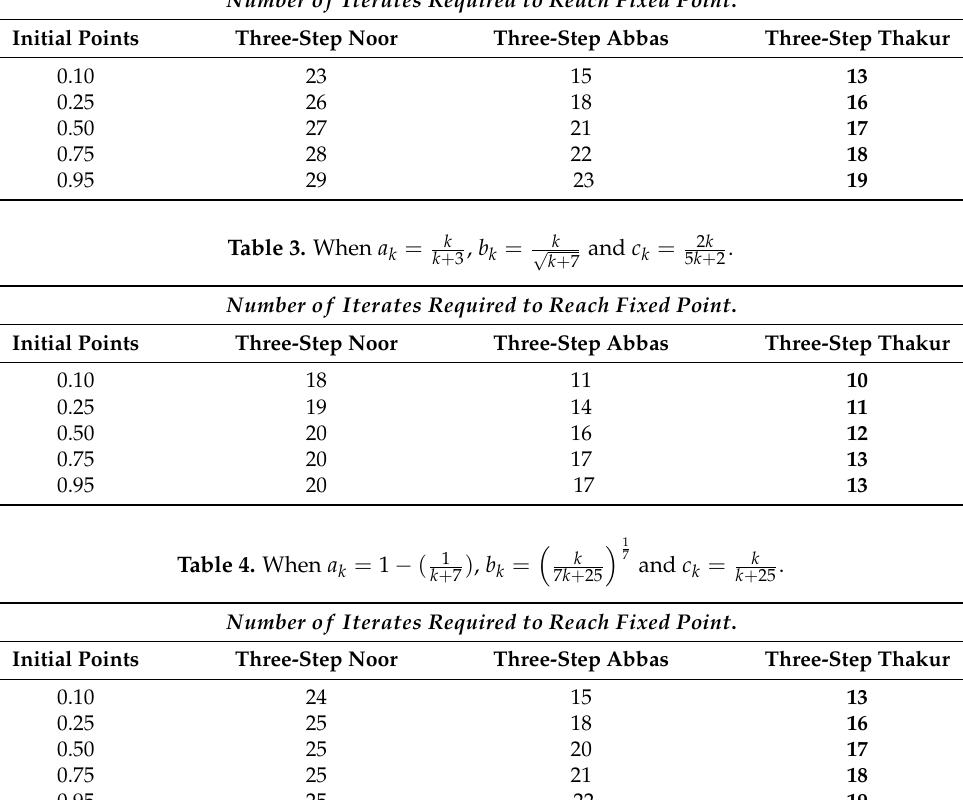
) 1 2 . , b k = k and c k = ( 1 k + 1 k + 7 3 k + 4